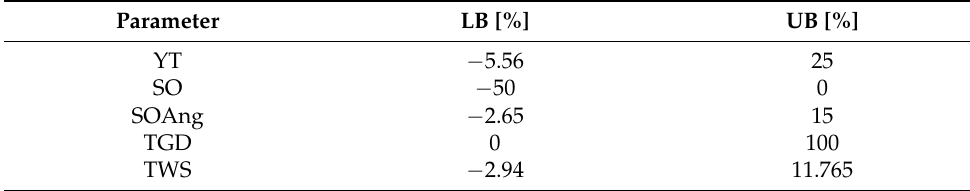
Table 1. Stator geometry DOFs considered for variation and their variation